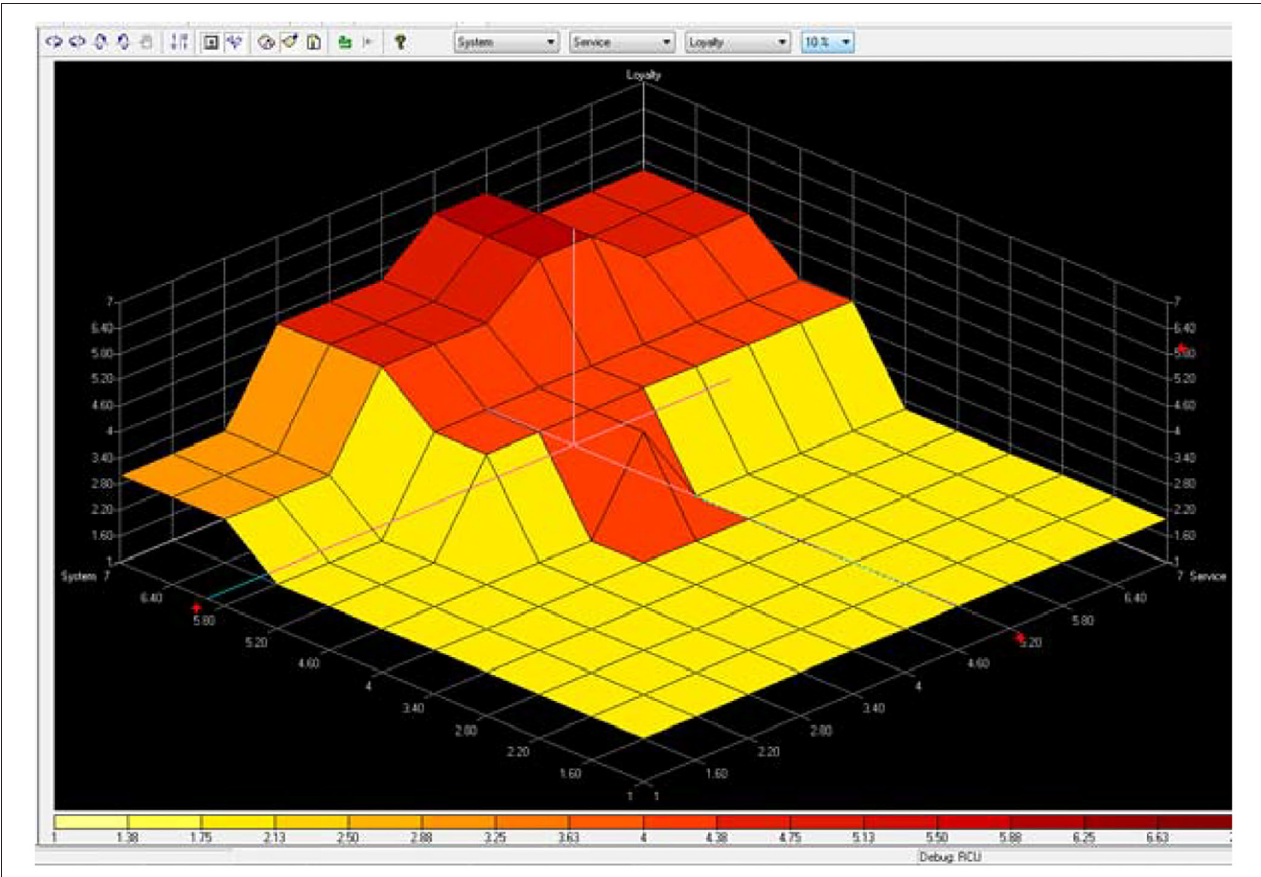
FIGURE 7 | Loyalty is positively to system and